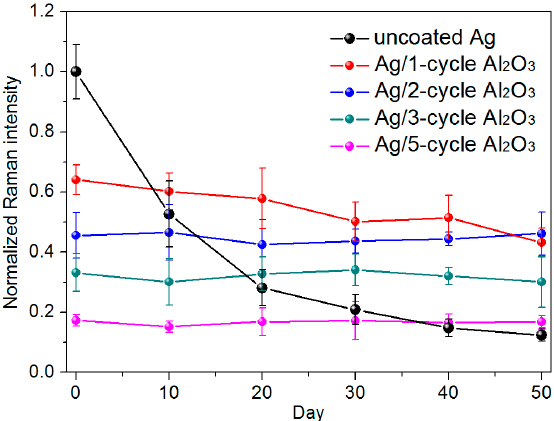
Figure 4. The normalized Raman intensities of 5 × 10 − 6 M MB Raman peak at 1622 cm − 1 on the uncoated AgNRs substrate and on AgNR arrays coated with Al 2 O 3 layers by 1, 2, 3, and 5 ALD cycles, as a function of the measurement time (Reprinted with permission from [49]).